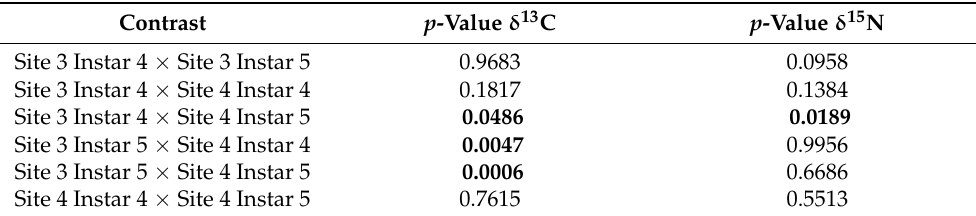
Figure 12. Stable isotope data for 4th and 5th instar Hydropsyche alternans from Sites 3 and 4. Posi- tions of Hydra (Cnidaria, Hydrozoa, and Hydridae) and Antocha (Insecta, Diptera, and Limoniidae) are included to show the relative positions of a trophic level 3 planktivore ( Hydra ) within this food web, and a trophic level 2 benthivore ( Antocha ) that commonly occurs in close association with Great Lakes surf zone Hydropsychidae retreats (Barton and Hynes 1978) [1]. Increasing trophic level is indicated by increasing δ 15 N values. Within this range, more negative δ 13 C values indicate pelagic (planktonic) energy. Less negative δ 13 C values indicate benthic energy. Antocha, Hydra , and Hydro- psyche alternans δ 15 N and δ 13 C data and δ 13 C data for Lake Superior surf zone epilithon are from [3]. Lake Superior offshore phytoplankton δ 13 C data are from [65].